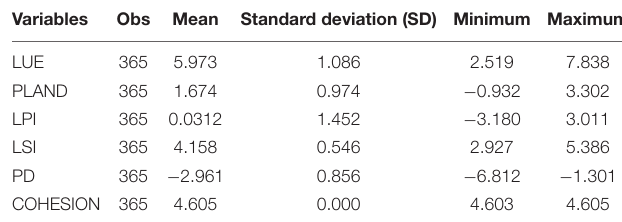
TABLE 2 | Descriptive statistics of all